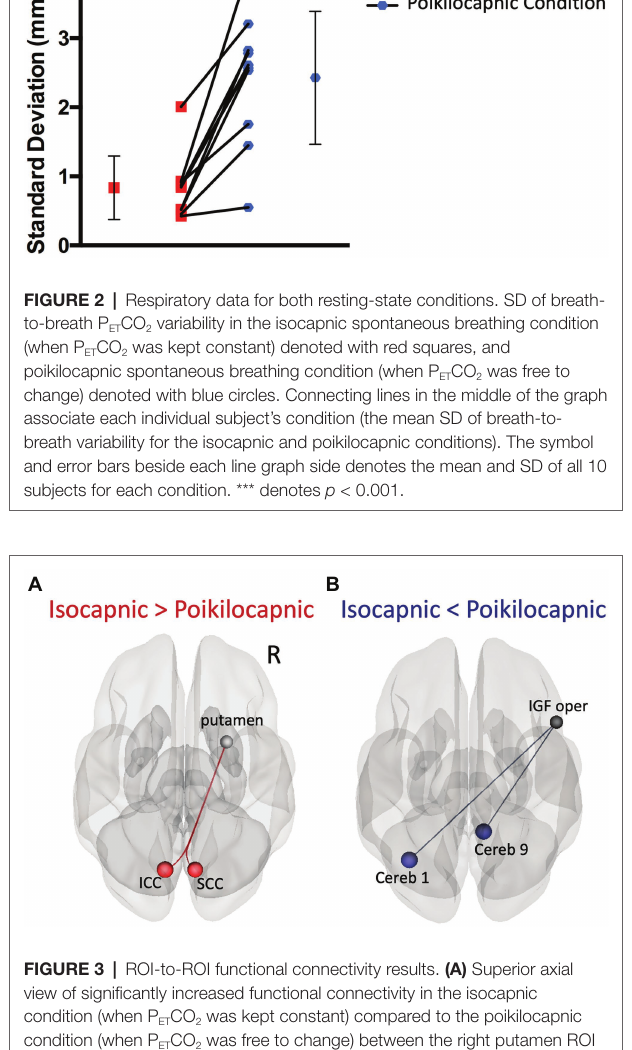
division of the right lateral occipital cortex ( Figure 4; Table 2 ).